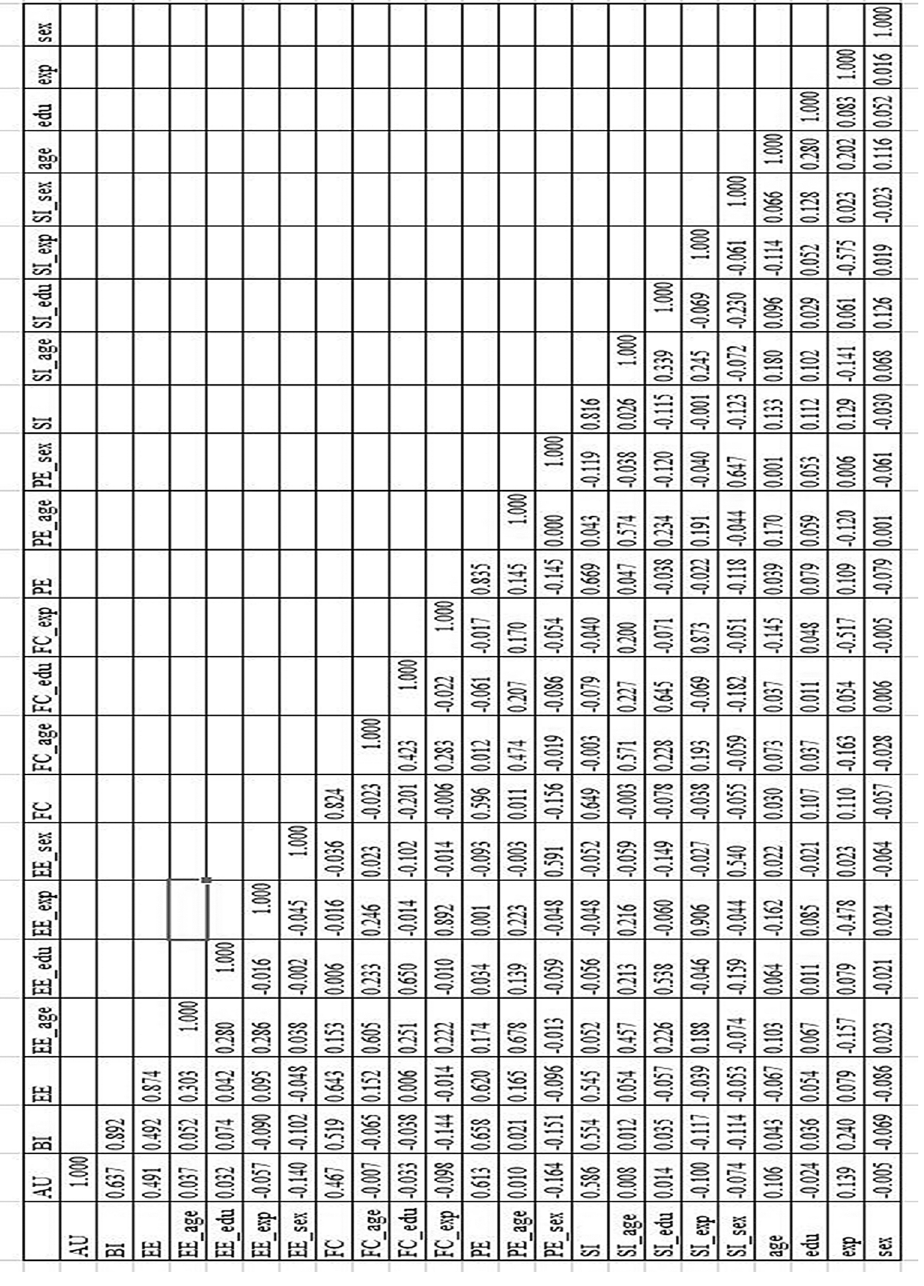
Figure 1. The results of discriminant validity